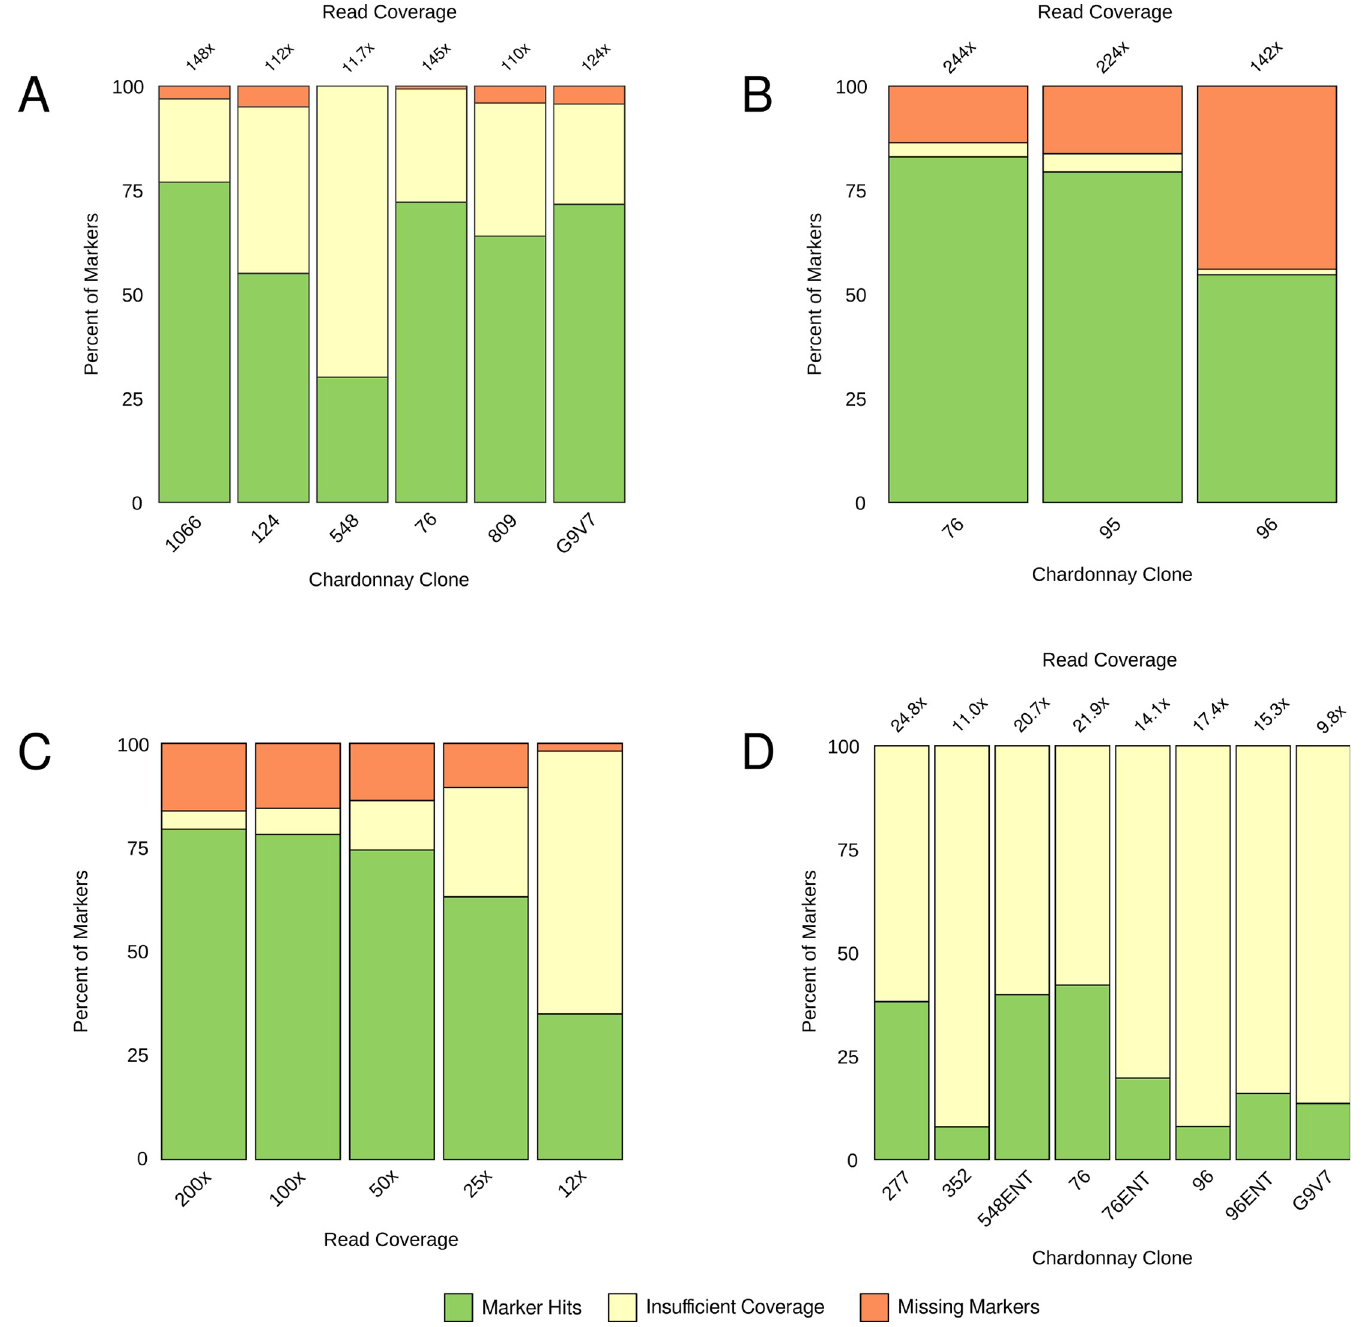
Fig 5. Validation of clonal markers for Chardonnay. Results of marker detection pipeline run on four WGS sequencing datasets. The percentage breakdown of clonal markers is shown as either markers identified in the datasets (marker hits), missing from the datasets (missing markers), or missing with low coverage at marker loci (insufficient coverage). (A) Moderate coverage sequencing replicates of marker discovery clonal material. (B) High-coverage sequencing of independently-sourced clonal material. (C) Coverage subsampling of independently-sourced clonal material (clone 95 from Fig 5B). (D) Low-coverage sequencing of DNA derived from several independently-sourced clones (‘ENT’ denotes ENTAV-INRA source